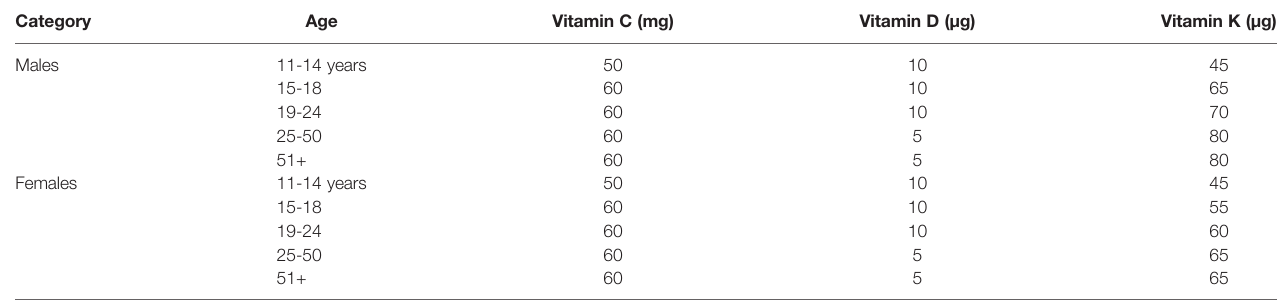
TABLE 3 | Daily Requirement of Vitamins for Different Aged People